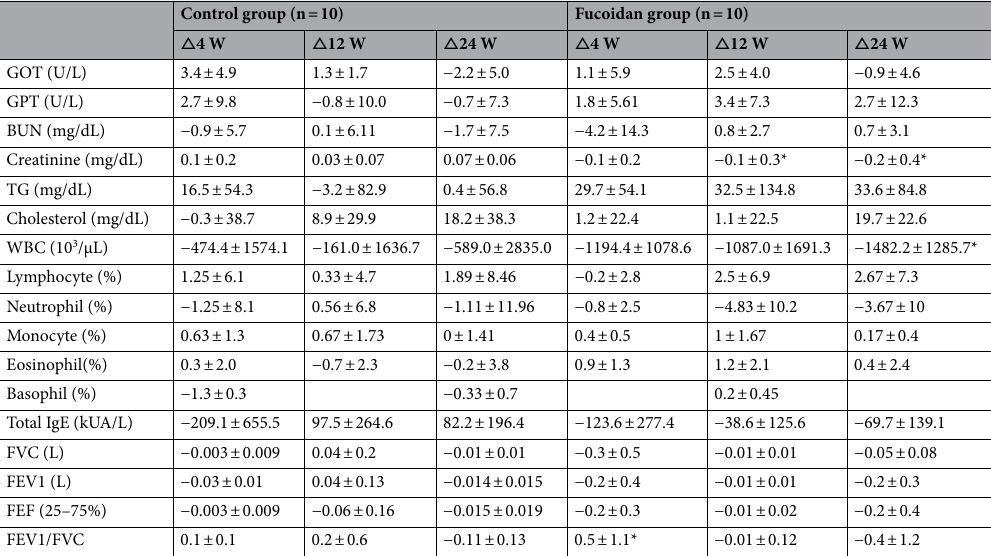
Table 2. The changed of biochemical data and lung function during supplementation period. △ : Indicates the data of week 4 or 12 or 24 minus the data of week 0. *: Indicates the data subtracted from the 4th week or the 12thweek or the 24thweek and the 0thweek, there is a significant difference between the control group and the fucoidan group (p <